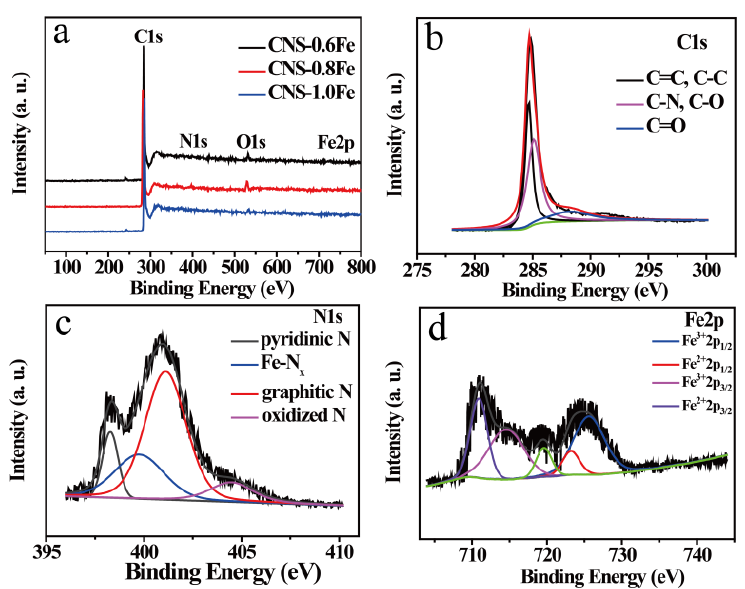
Figure 6. ( a ) XPS survey spectra of CNS–0.6Fe, CNS–0.8Fe and CNS–1.0Fe. High-resolution XPS spectra of ( b ) C 1s, ( c ) N 1s, ( d ) Fe 2p of Table 2. Contents (at.%) of nitrogen with different chemical environments calculated from the N1s XPS spectra.